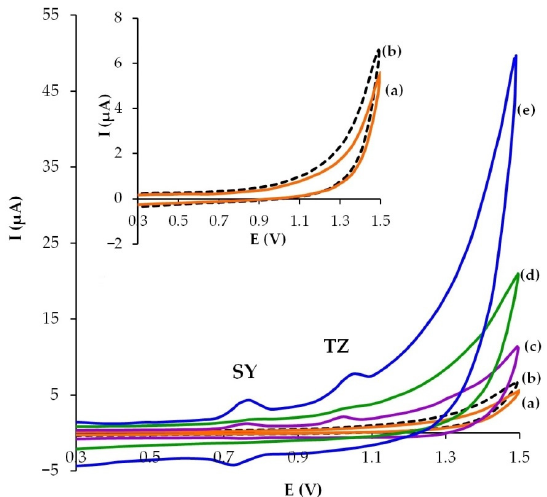
Figure 3. Cyclic voltammograms of 10 μ M SY and TZ on the bare CP electrode ( b ) and the CP electrodes modified with GR ( a ), MWCNTs ( c ), CB ( d ), GrP ( e ). Supporting electrolyte: phosphate buffer solution pH 5, ν = 50 mV s − 1 .